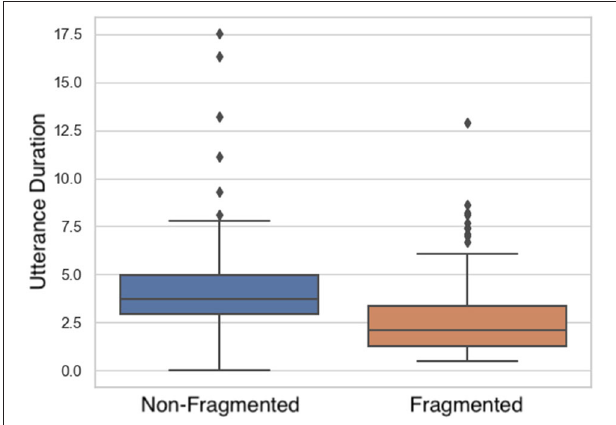
FIGURE 8 | Differences in utterance duration (in seconds) among non-fragmented and fragmented instructions.